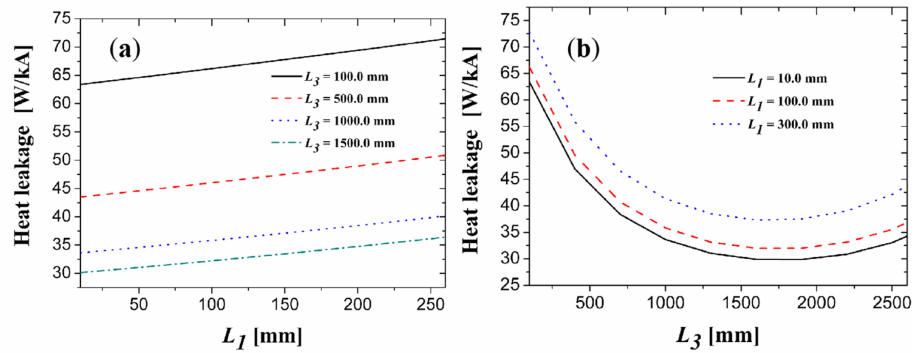
Figure A5. Iteration step 2: the coupling influence between B ( L 1 ) and C ( L 3 ) on the cold end heat leakage of PCLs (keeping parameters r 1 = 5.0 mm, r 2 = 10.0 mm, L 2 = 7.0 mm unchanged, in this iteration Q min = 29.9 W/kA). ( a ) The heat leakage vary with B ( L 1 ); ( b )The heat leakage vary with C ( L 3 ).